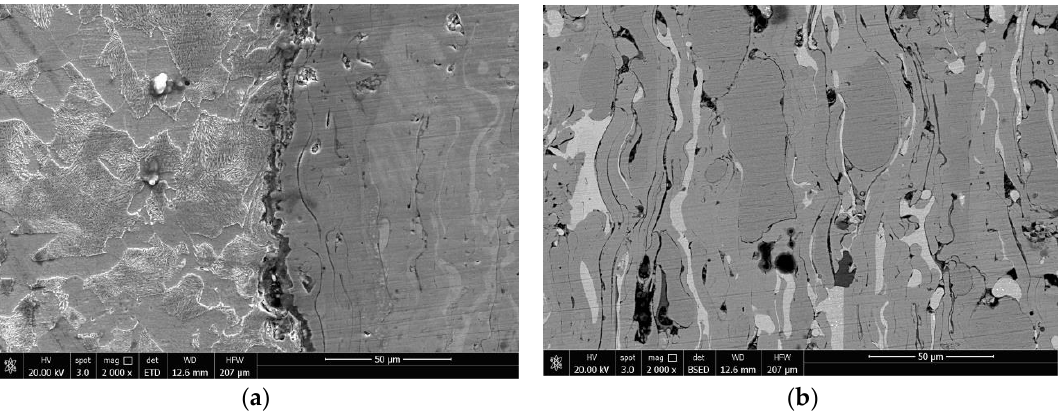
Figure 1. Interface morphology and cross section morphology of plasma sprayed coatings: ( a ) interface morphology; ( b ) coating morphology .